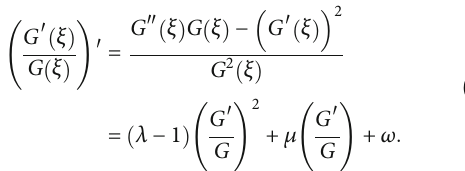
Figure 5: Snapshots of soliton solution to periodic solution of solution (60b) for various values of α , and c = 1/2 ffiffiffiffiffiffiffiffiffiffiffiffiffiffiffiffiffiffiffiffi p ffiffiffi p E λ 2 − 4 E μ , λ = 2 , μ = 0 : 4, A = 3, and When β = 1, c = E = 0 : 5 , the graphical form of solution (78) of equation (5) changing with α is shown in Figure 2. When α = 1, c = ffiffiffiffiffiffiffiffiffiffiffiffiffiffiffiffiffiffiffiffi p ffiffiffi p , λ = 2 , μ = 0 : 4, A = 3, and E = 0 : 5 , the graphi- E λ 2 − 4 E μ